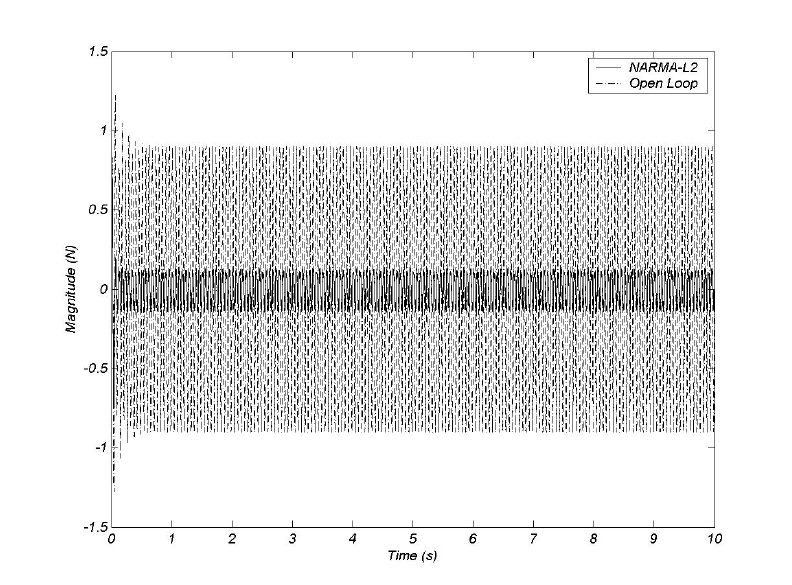
Fig. 27. Transmitted force variations of the system using the NN controller subjected to periodic engine disturbance at 18 Hz. Open loop (–) and NN controlled (solid). the chassis. However, unlike the conventional controllers at the idling frequency the NARMA-L2 controller shows no phase